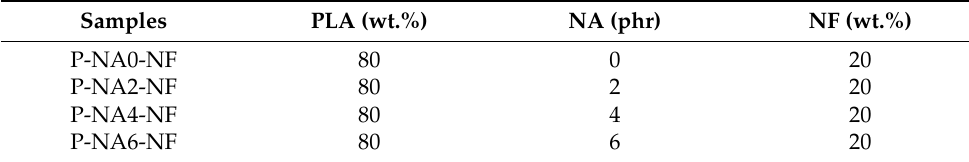
Table 1. PLA/NA/NF formulation for the composite preparation.